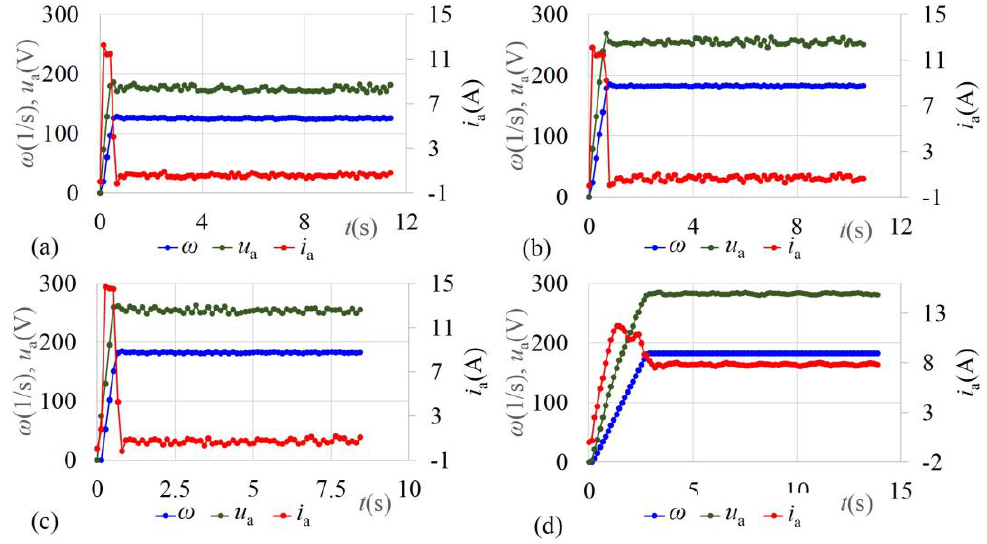
Figure 7. Measured input responses: ( a ) MD1; ( b ) MD2; ( c ) MD3; ( d ) MD4.